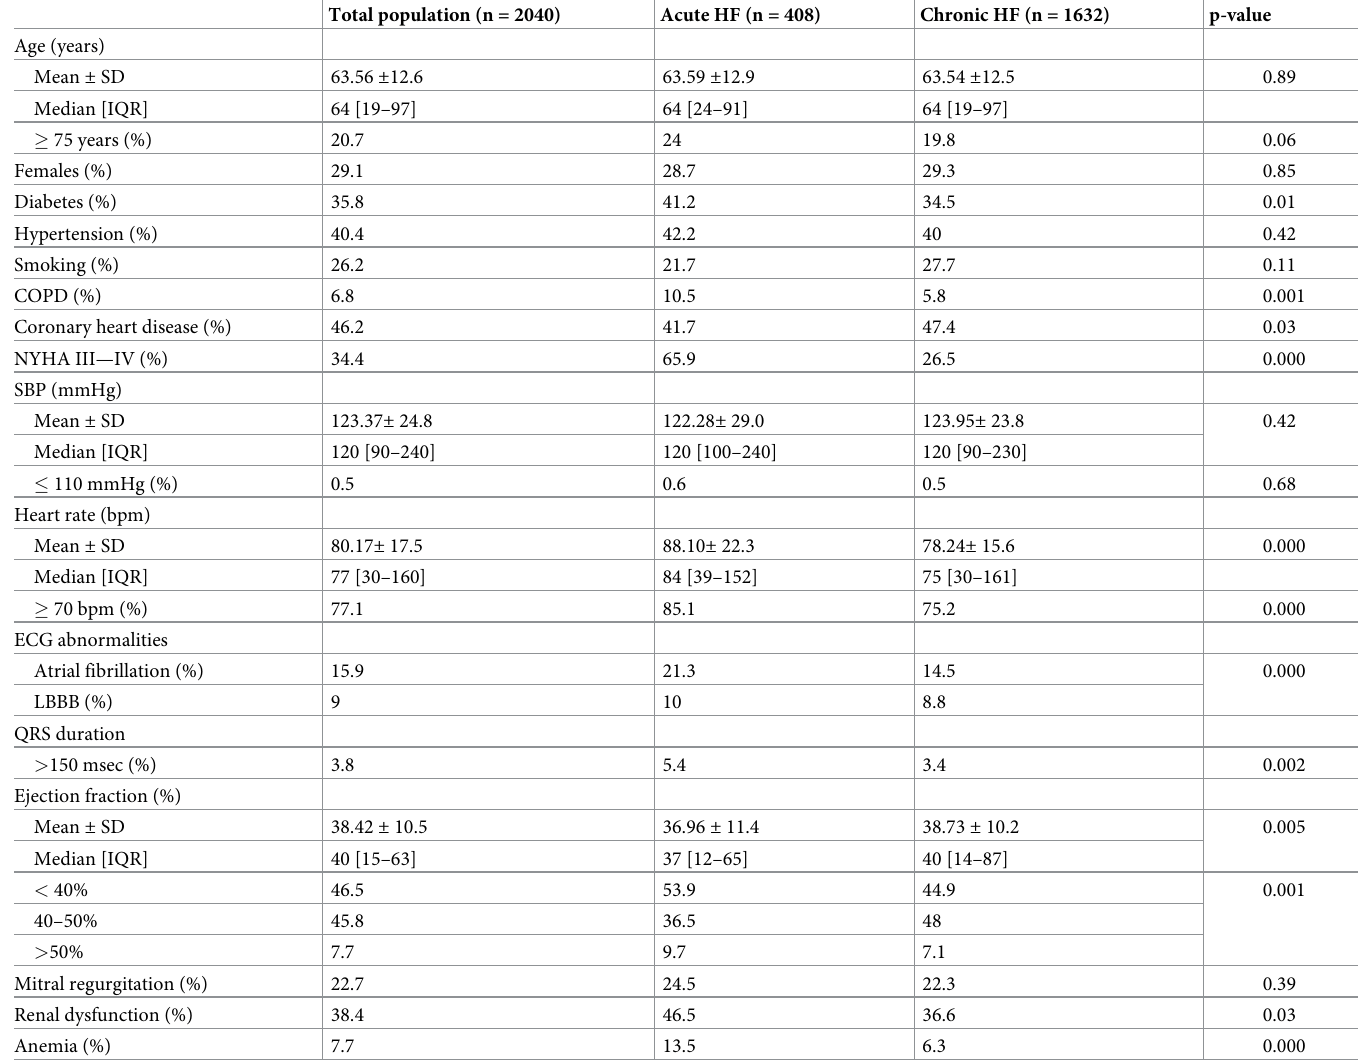
Table 1. Baseline characteristics of the study